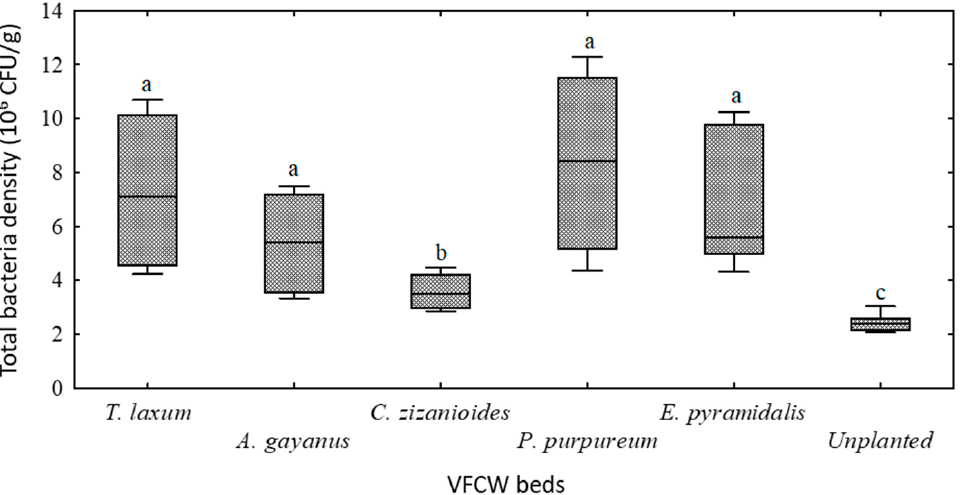
Figure 3. Variation of total bacteria density in the pilot VFCWs substrate at the end the treatment trial. Box-plots bearing the same letter indicate no significant difference ( p > 0.05).